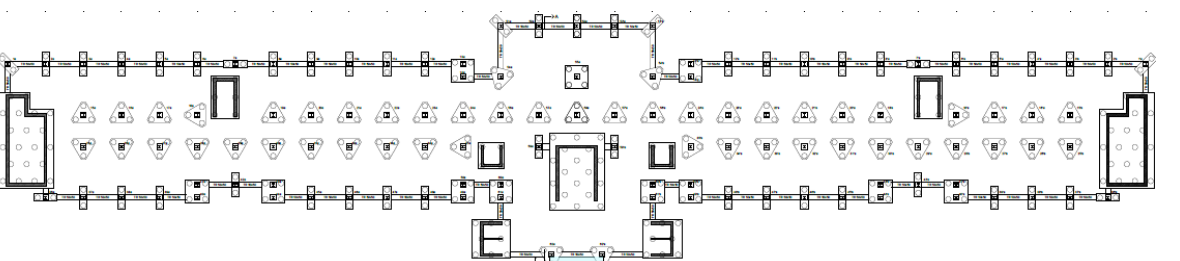
Figure 5. Foundation plan of the Day-Hospital Building.